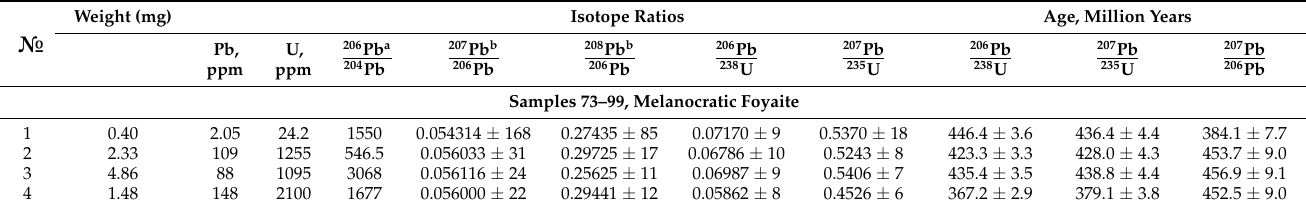
Table 1. U-Pb isotopic data for the Saibar intrusion.